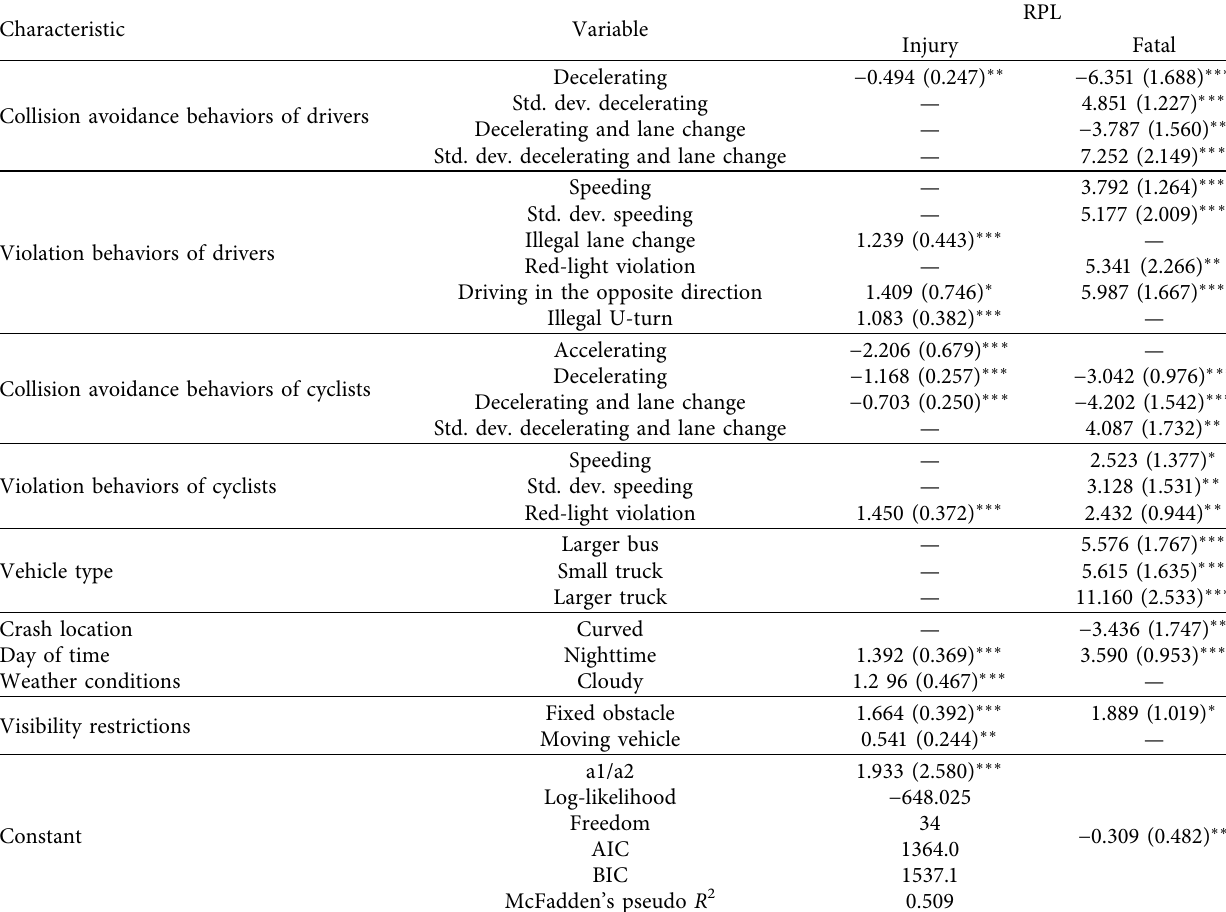
Table 2: Coefficients (and standard errors) of the RPL model for cyclist injury severity